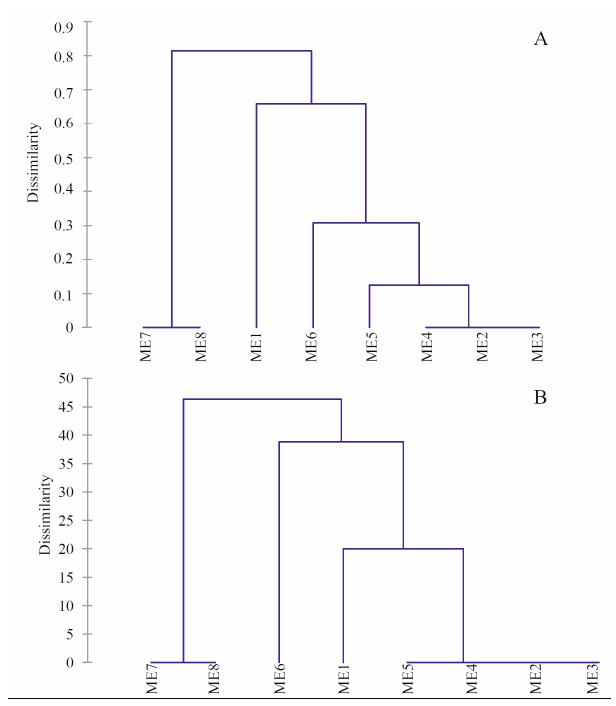
Fig. 3 ­ UPGMA clusters of 8 pomegranate accessions generated by RAPD markers using the Jaccard similarity coefficient (A) and by SSR markers using Manhattan distance (B).